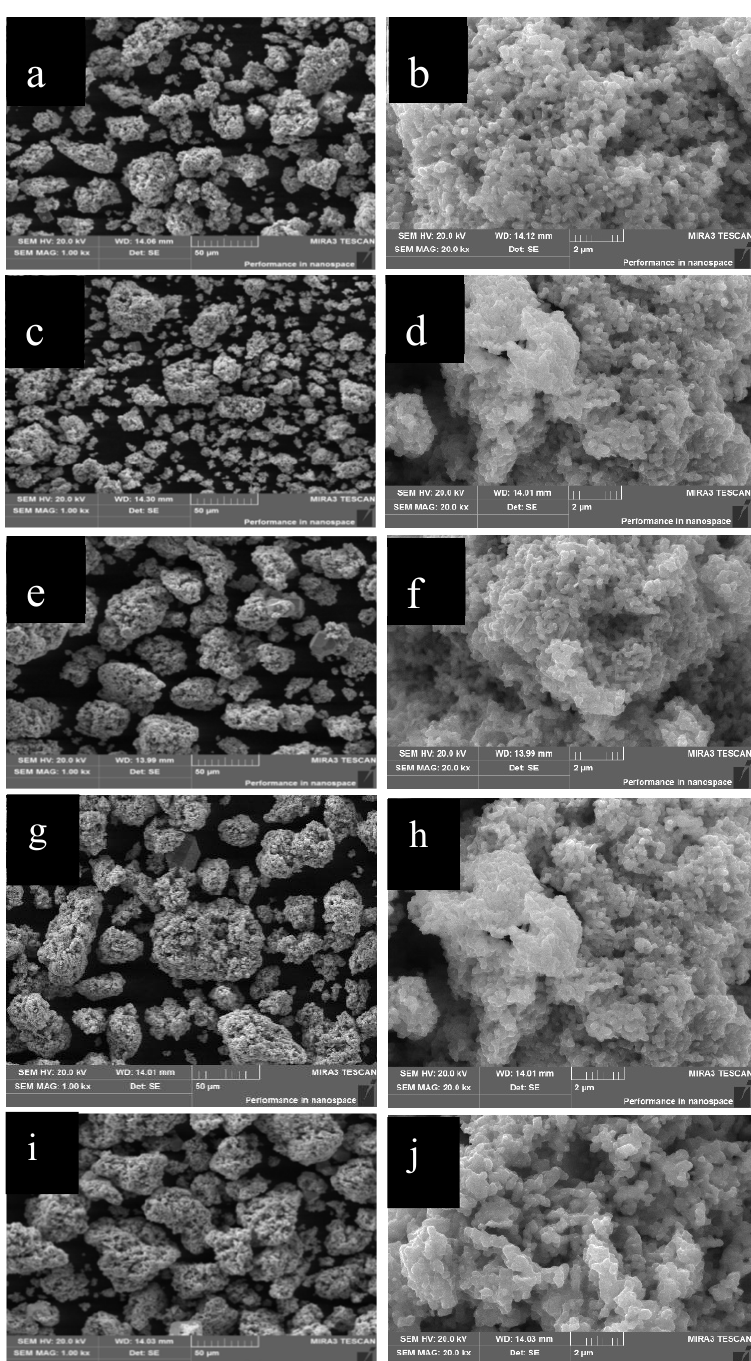
Figure 2. The morphology SEM images of different copper sulfides ( a , c , e , g , i ) (CuS, Cu 7 S 4 , Cu 9 S 5 , Cu 7.2 S 4, and Cu 2 S), whose particle diameter is 55 μ m; Figures ( b , d , f , h , j ) are enlarged image part of figures ( a , c , e , g , i ).